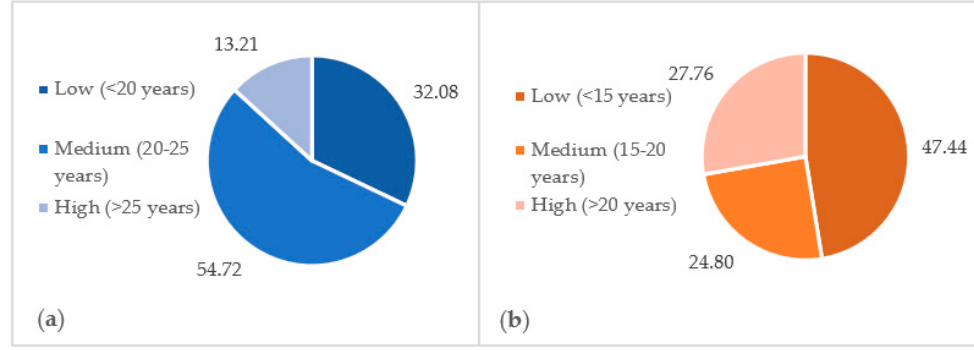
Figure 6. Age of infrastructure, ( a ) water mains, ( b ) service connections.